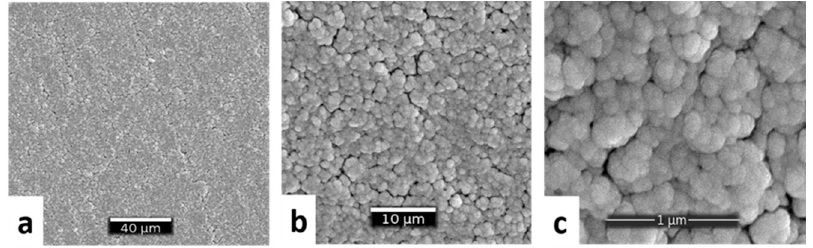
Figure 8. Corresponding SEM images of copper deposited by magnetron sputtering on CNW and steel substrate at different magnifications: ( a ) 10,000×, ( b ) 20,000×, ( c ) 40,000×.